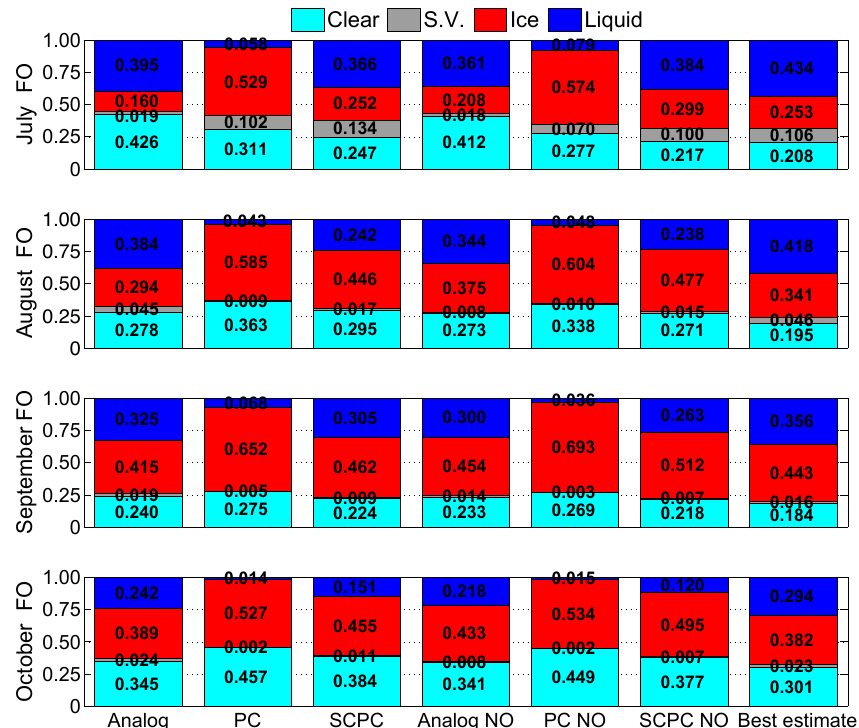
Figure 5. Fractional occurrence (FO) of each voxel type in the column for July 2015 to October 2015. To be labeled clear, the column must lack all sub-visible, ice, and water voxels. To be labeled sub-visible, the column must lack ice or water voxels. To be labeled as ice, a column must lack water voxels. If a column contains a water voxel, the column is labeled as liquid. The FO is given for each bar rounded to the nearest thousandth.